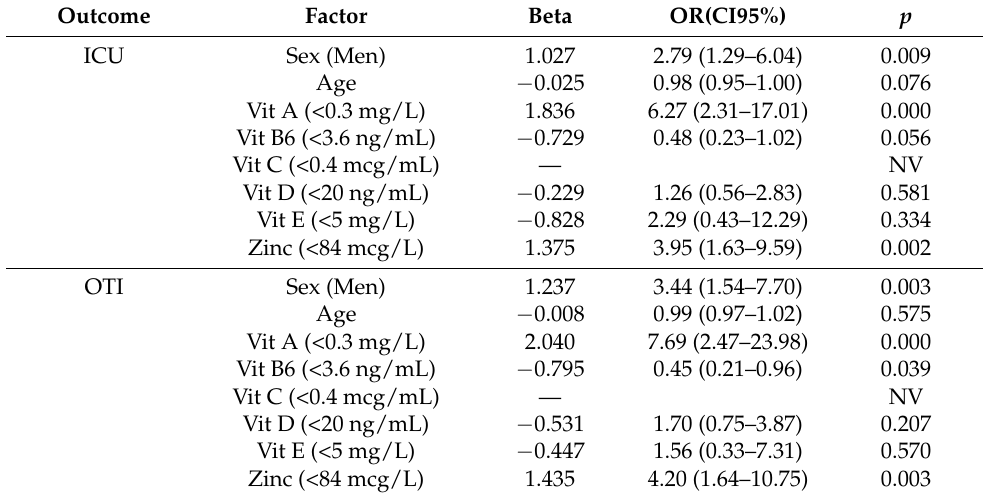
Table 4. Results of the bivariate logistic regression between the low levels of each micronutrients and outcomes (ICU and OTI).